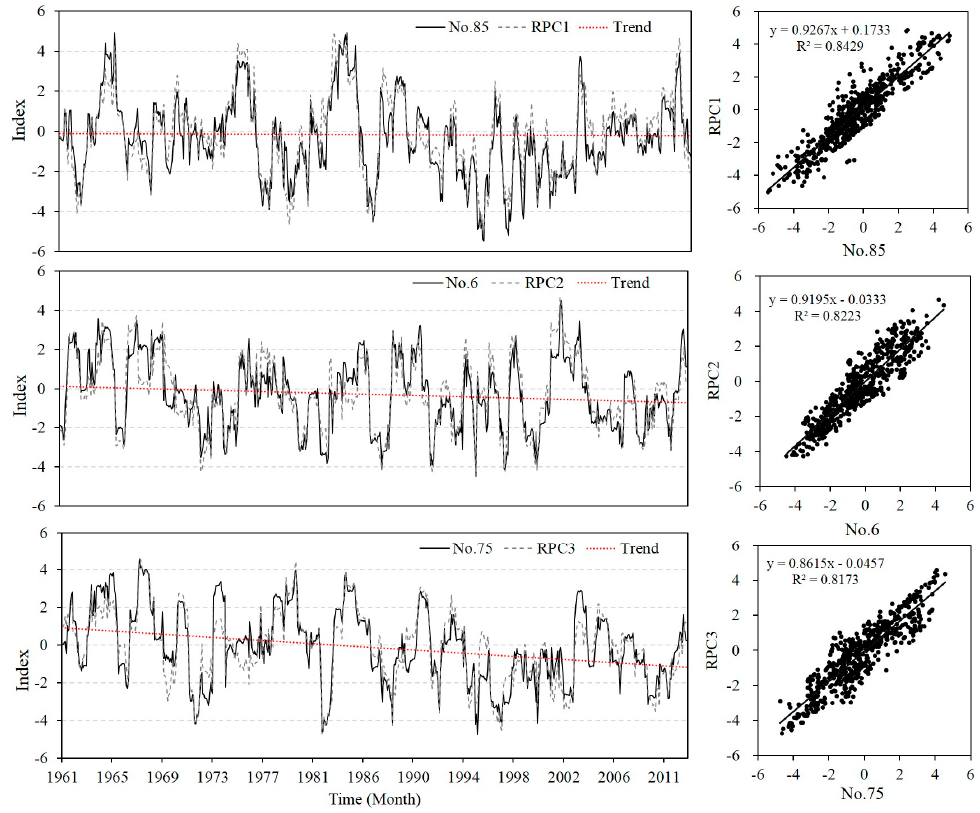
Figure 11. Temporal patterns of drought severity based on PDSI_SWAT for the rotated principal component (PC) scores and the corresponding representative sub-basins (No. 85, No. 6 and No.